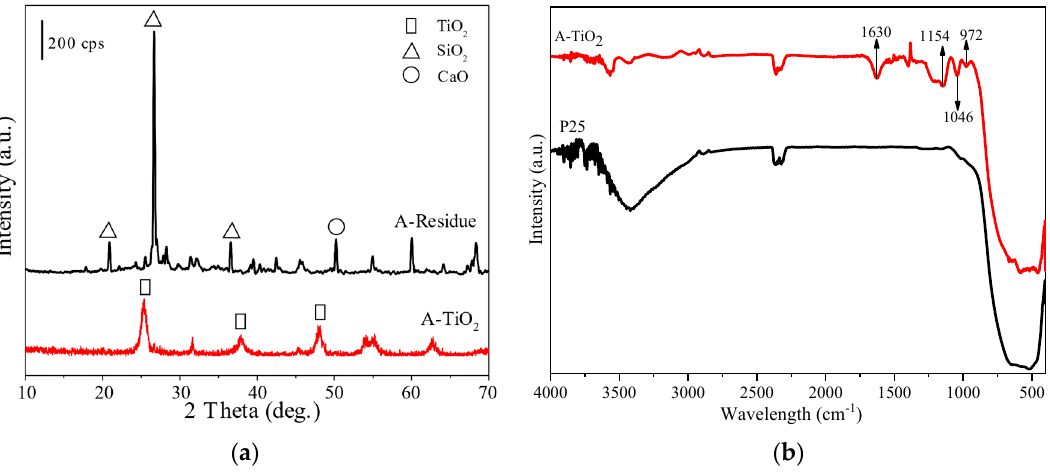
Figure 3. ( a ) X-ray diffraction (XRD) patterns, ( b ) Fourier transform infrared (FT-IR) spectra of A-Residue and A-TiO 2 prepared from algal turbid water.